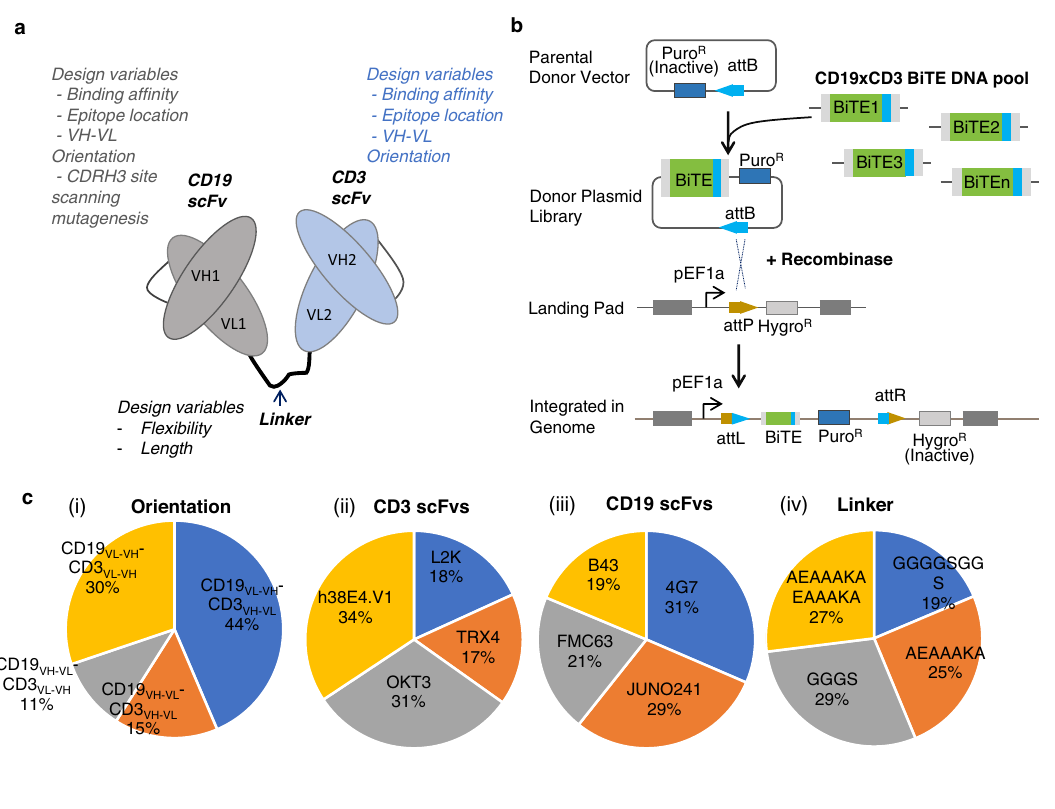
Fig. 2 BiTE library generation and characterization of integrated library diversity. a Design variables interrogated for the CD19 scFvs CD3 scFvs, and peptide linker connecting the scFvs. b Schematic representation of the integration of single copy BiTE variant in landing pad harboring HEK293 cell line (HEK293_LP) with promoterless BiTE gene encoding donor plasmid library. c Representation of diversity of BiTE design features obtained from long-read amplicon sequencing (PacBio SMRT) of PCR ampli fi ed BiTE genes from genomic DNA of BiTE integrated HEK293_LP cells, distribution of relative orientation of scFvs (i), Distribution of relative CD3 scFvs (ii), Distribution of CD19 scFvs (iii) and Distribution of scFv interconnecting linkers (iv). ~22,300 unique BiTE sequences obtained from long-read amplicon sequencing were used for analyzing the distribution of design parameters (relative scFv orientation, CD3 scFv type, CD19 scFv type, and scFv interconnecting linker type). The genomic DNA template used for amplifying integrated BiTE